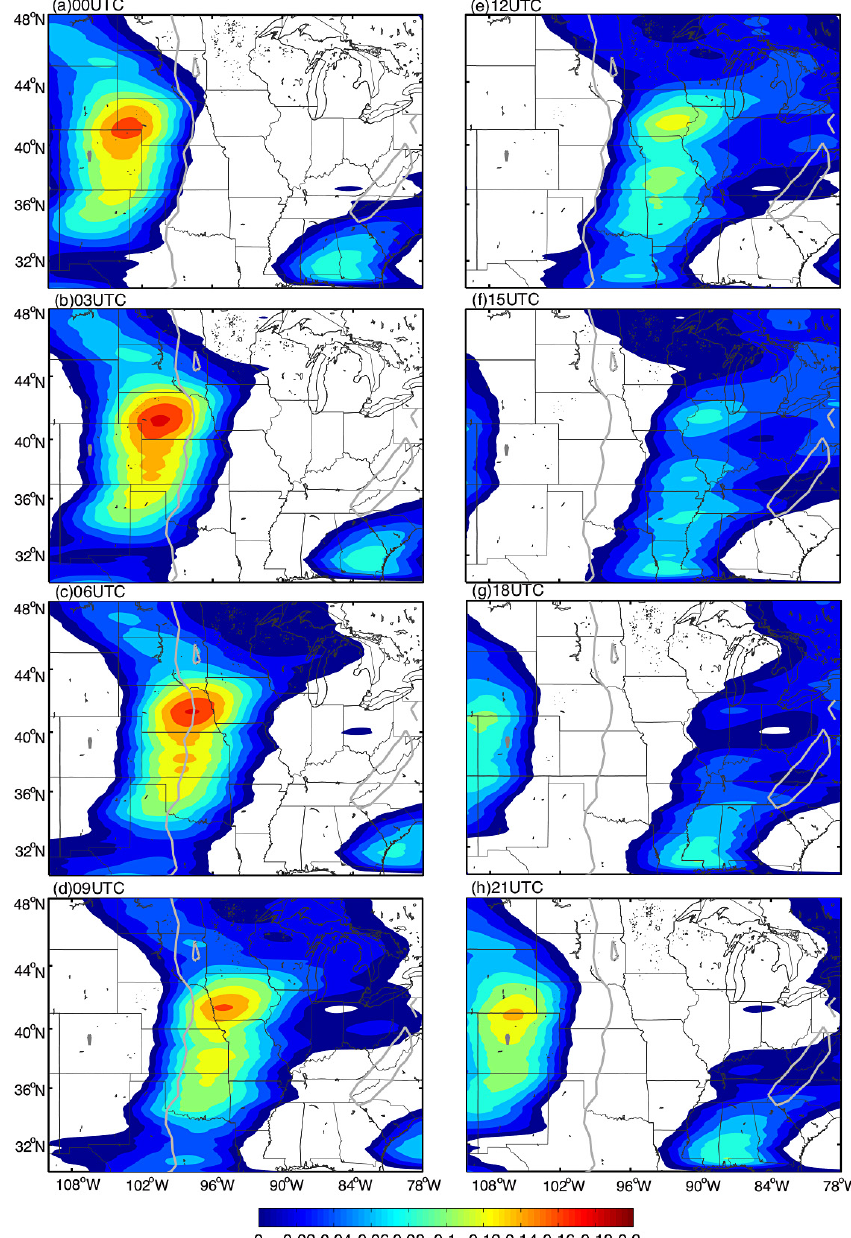
Figure 15. Similar to Fig. 13 but for SR1-filtered perturbations (units: mmh − 1 ) over North America.